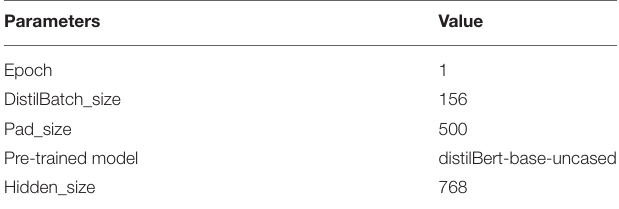
TABLE 4 | Parameters of the distilBert model.